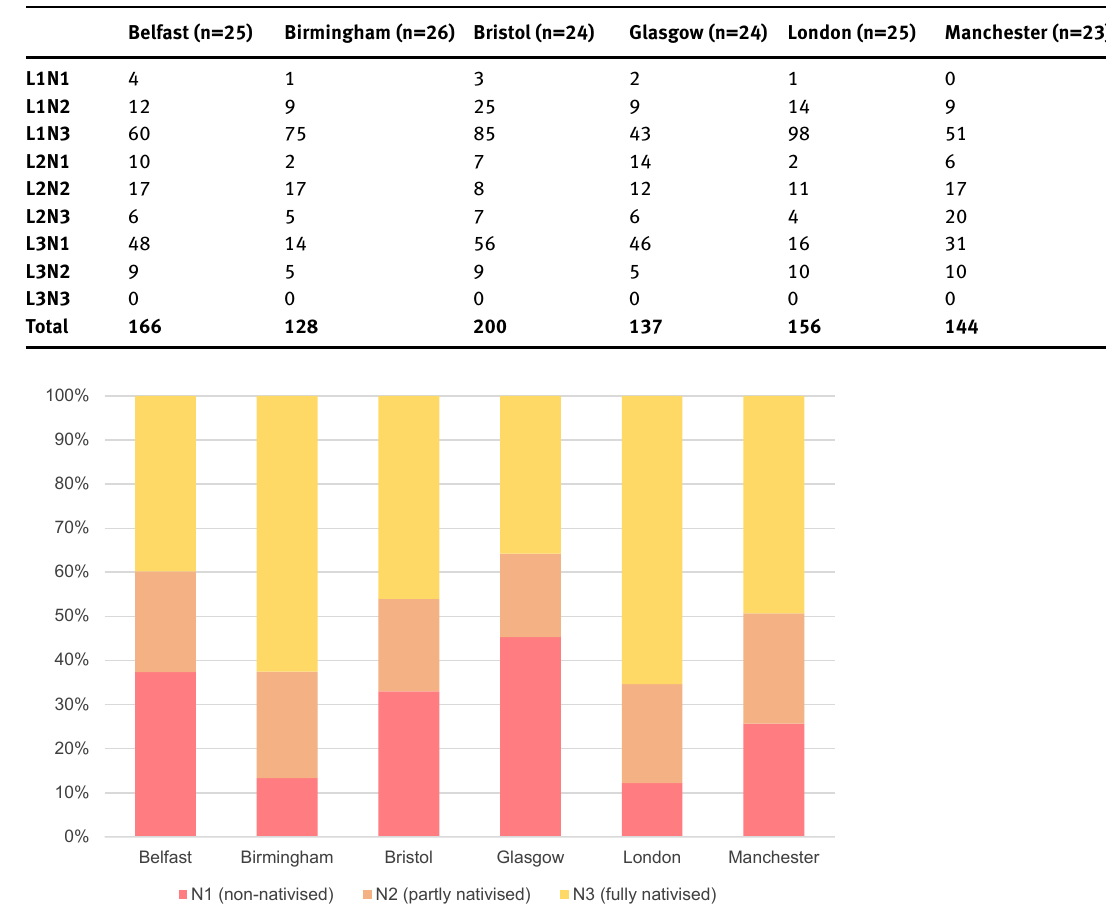
Figure 11: Distribution of fingerspelling-related tokens across nativisation model (N only) per region